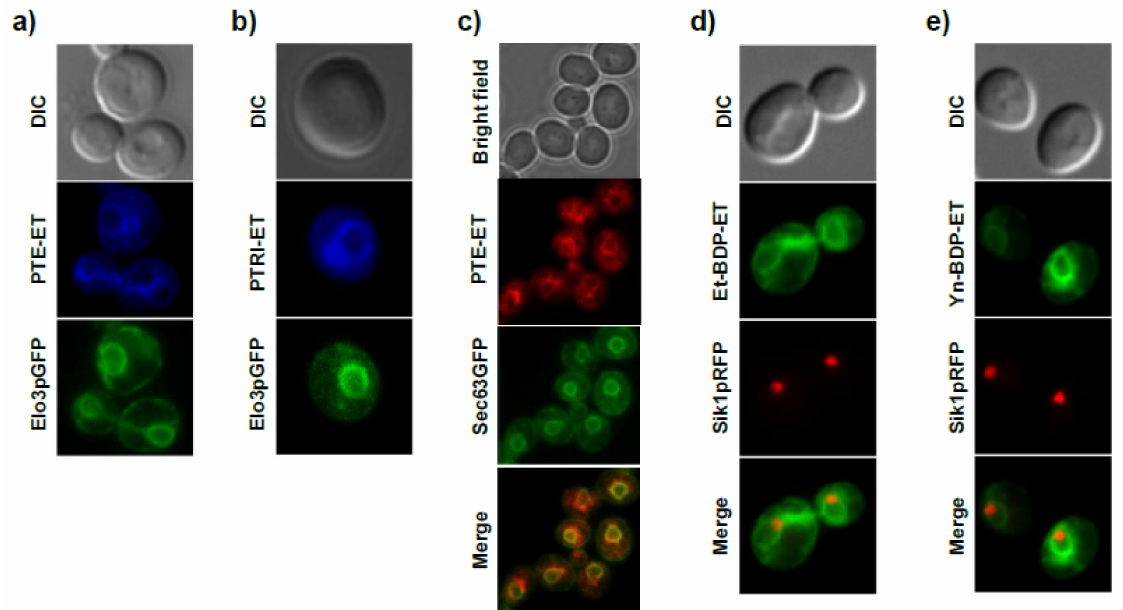
Figure 8. Localization of edelfosine in the ER of Saccharomyces cerevisiae . The fluorescent edelfosine analogs ( a ) PTE-ET and ( b ) PTRI-ET localize in the ER, as shown by their colocalization with the ER marker Elo3pGFP. ( c ) The